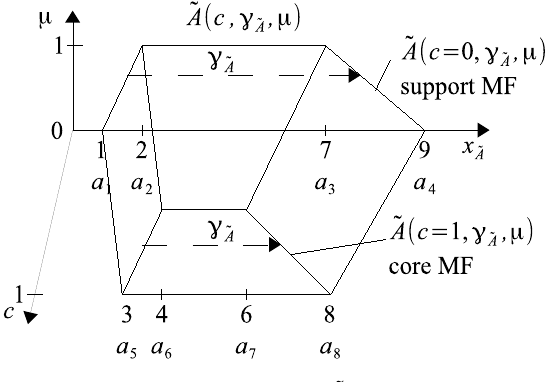
Figure 14. Type-2 fuzzy number ˜ A in 3D space.